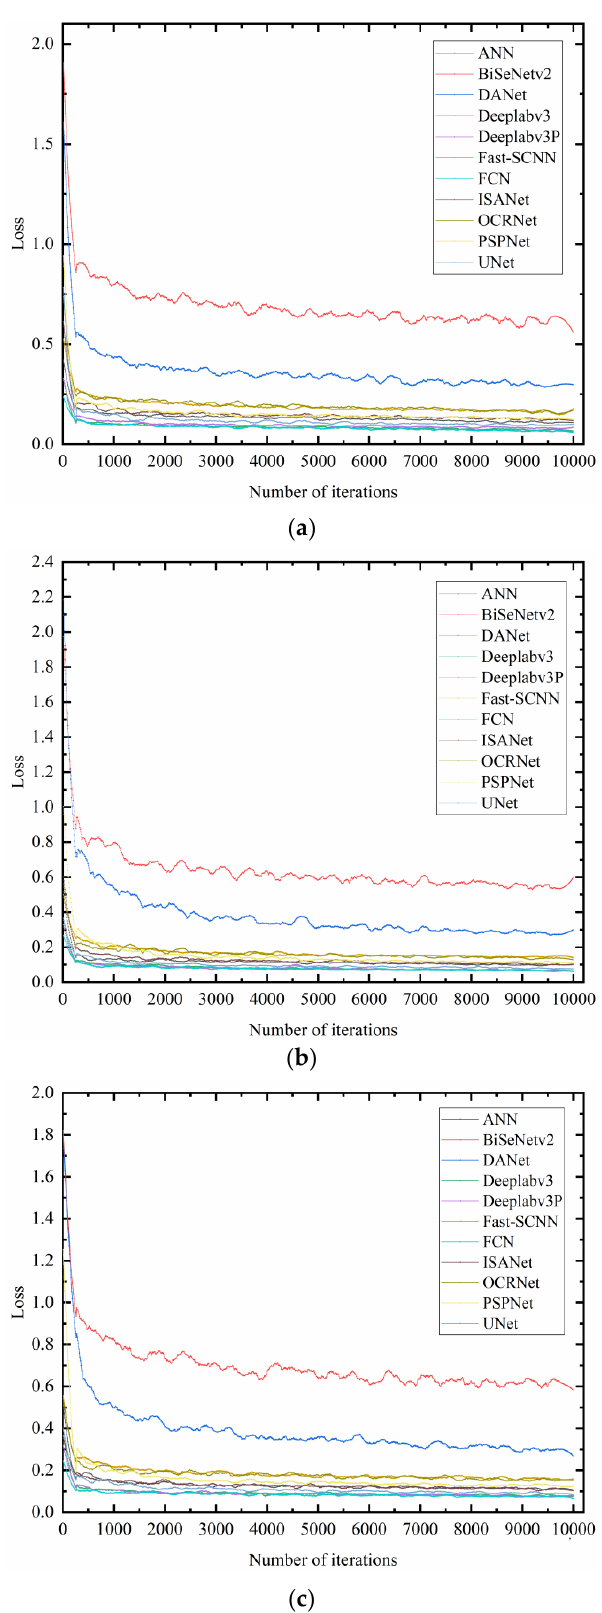
Figure 12. Loss of 11 models on the three types of datasets: ( a ) left eye, ( b ) right eye, and ( c ) left and right eyes with iterations.